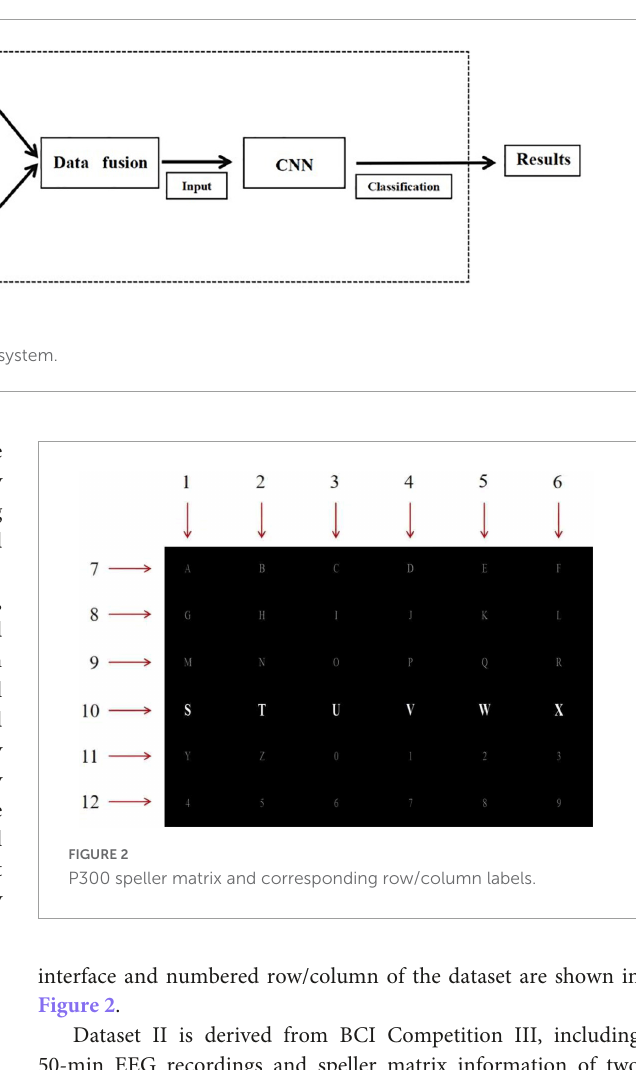
interface and numbered row/column of the dataset are shown in Figure 2